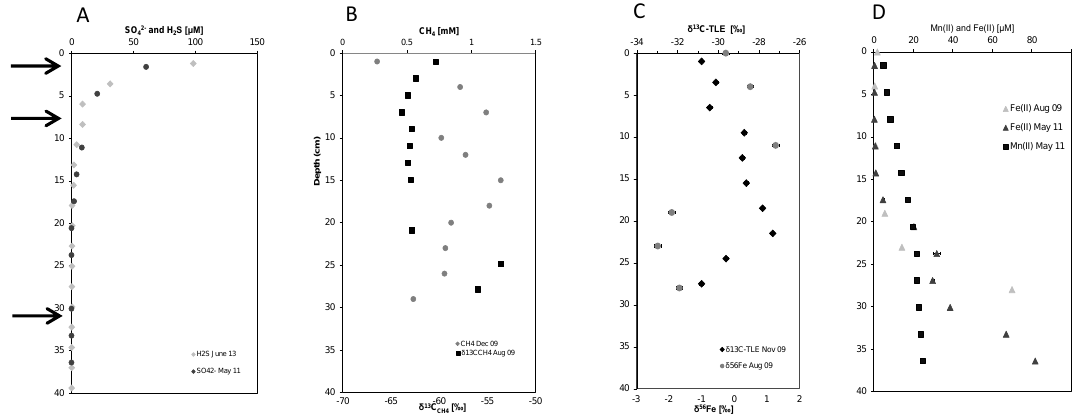
Figure 2. Geochemical porewater profiles in LK sediment. (a) Profile of SO − 2 (black circles) and sulfide (gray diamonds) in the porewa- 4 ter (b) . Headspace measurements of methane (gray circles) and δ 13 C CH (black squares) in the sediments (c) δ 13 C of total lipids extraction 4 (TLE; black diamonds) from the sediment, and δ 56 Fe (gray circles) of the dissolved iron in the porewater. (d) Electron acceptor profiles of dissolved Fe(II) (gray triangles) and Mn (II) (black squares) in the porewater. Black arrows indicate the sampled sections for 16S rRNA gene analysis. The presented methane profile was taken 2 weeks prior to the sampling for the microbial communities on December 2009. Sampling for Fe(II), Mn(II) and SO − 2 profiles was carried out between 2007 and 2011 and for sulfide between 2007 and 2013. The δ 13 C CH 4 4 and δ 56 Fe profiles were performed 4 months prior to the microbial sampling on August